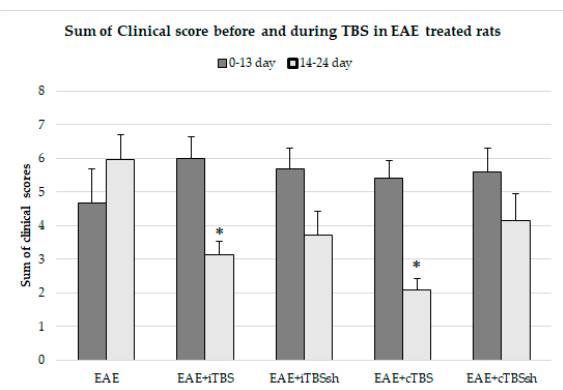
Figure 2. Summarized daily scores of EAE clinical symptoms before and during the TBS or sham TBS of EAE rats. The number of rats per group was 8. The totals of daily EAE clinical symptoms scores were calculated for 0–13th dpi (bottom part of the bars) and during 14–24th dpi (upper part of the bars). Clinical symptoms were numerically evaluated (see Figure 1 capture). The statistical significance when compared to the EAE group was considered at * p < 0.05.